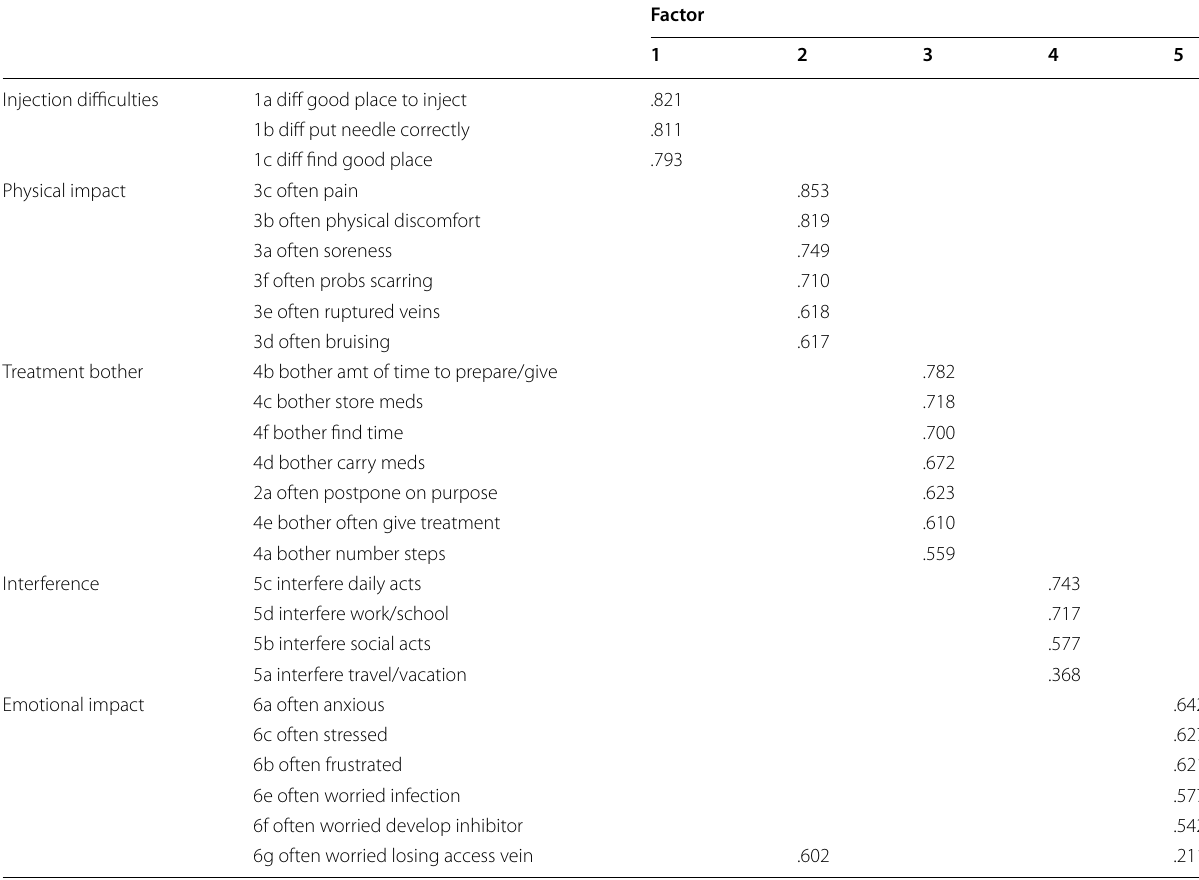
Table 6 Hemo-TEM factor analysis (26 items)